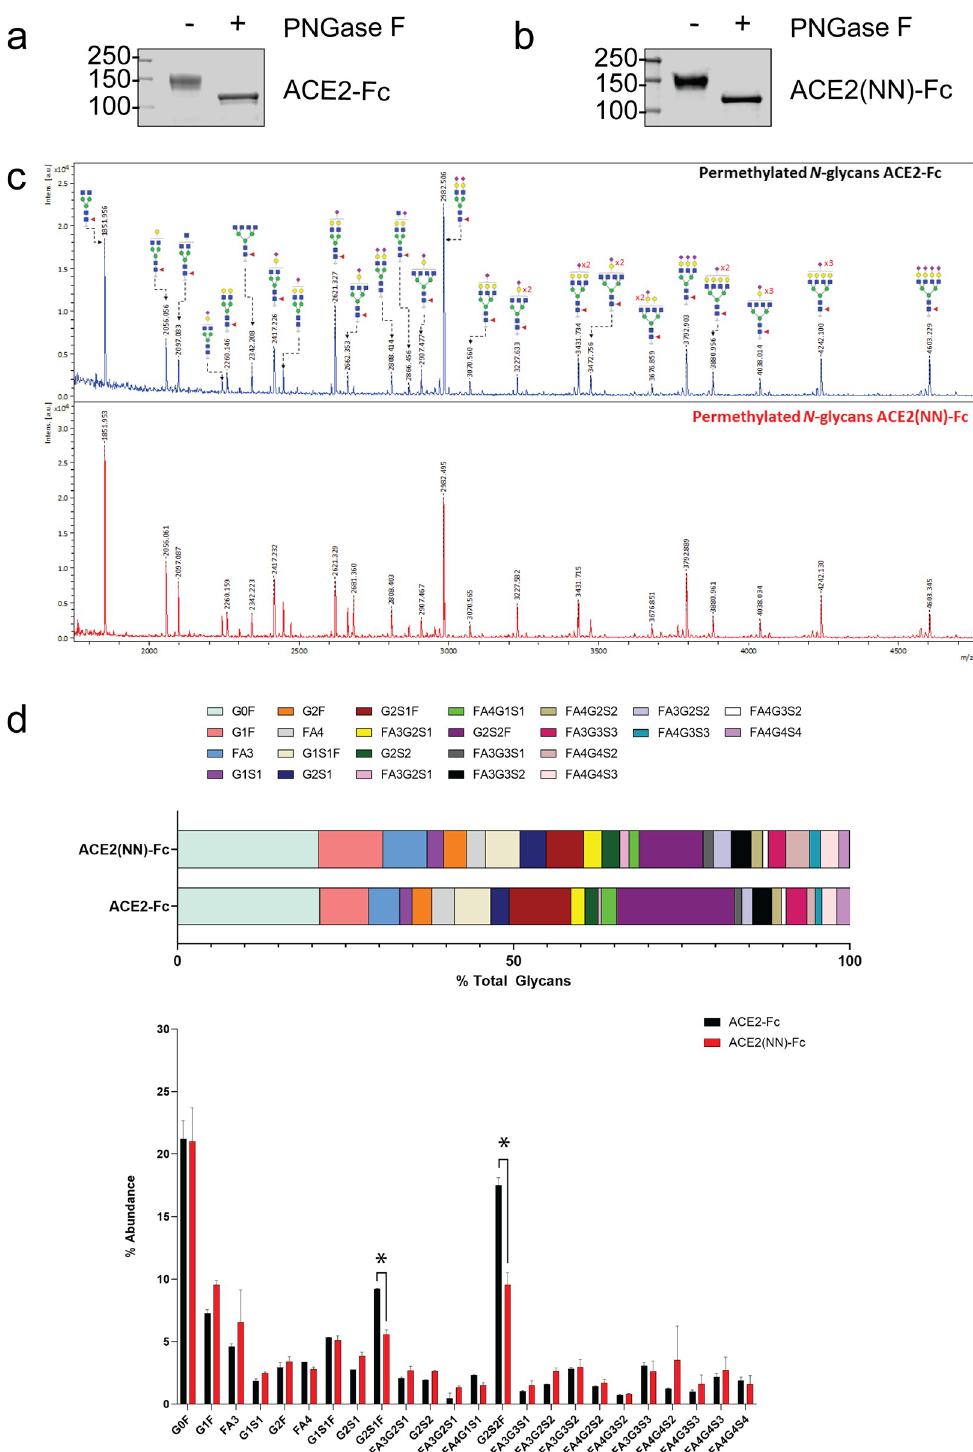
Fig 3. ACE2-Fc and ACE2(NN)-Fc fusion proteins are heavily glycosylated with complex-type N-glycans. Reduced SDS-page of ACE2-Fc ( a ) and ACE2(NN)-Fc ( b ) before and after treatment with PNGase F. ( c ) MALDI-TOF-MS spectra of permethylated N-glycans identified in ACE2-Fc (top) and ACE2(NN)-Fc(bottom). ( d ) Relative abundance of N-glycan peaks identified in ACE2-Fc and ACE2(NN)-Fc (Top), and comparison in percentage abundance of N-glycans identified in 3 batches of ACE2-Fc and 3 batches of ACE2(NN)-Fc (bottom).